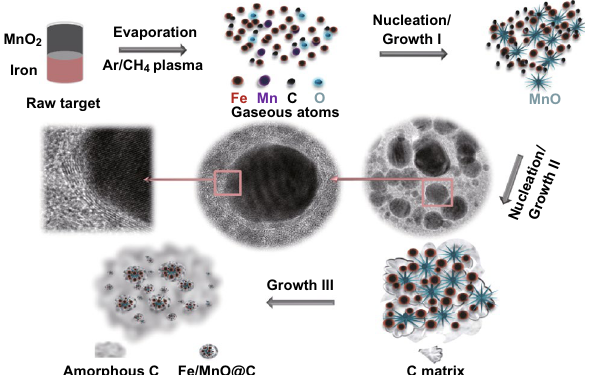
Fig. 4 Schematic diagram for formation of FMCA